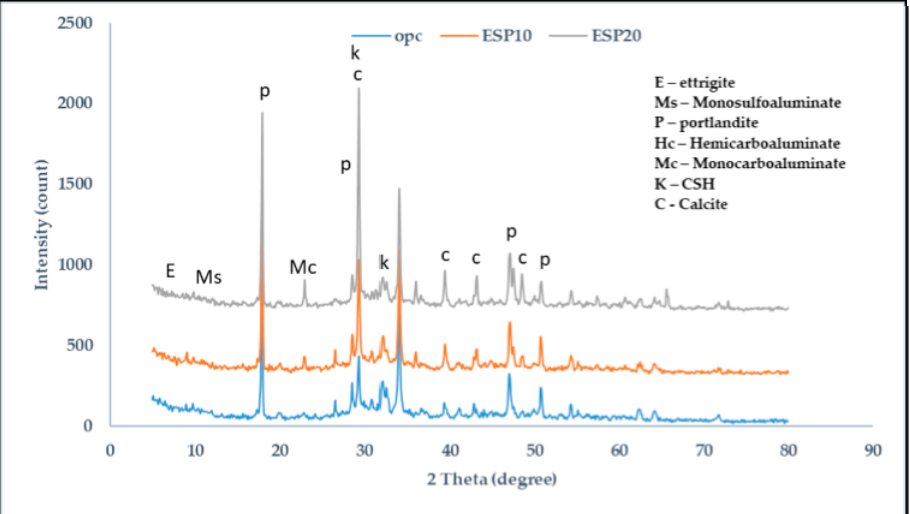
Figure 7. XRD analysis of 28-day cement paste.